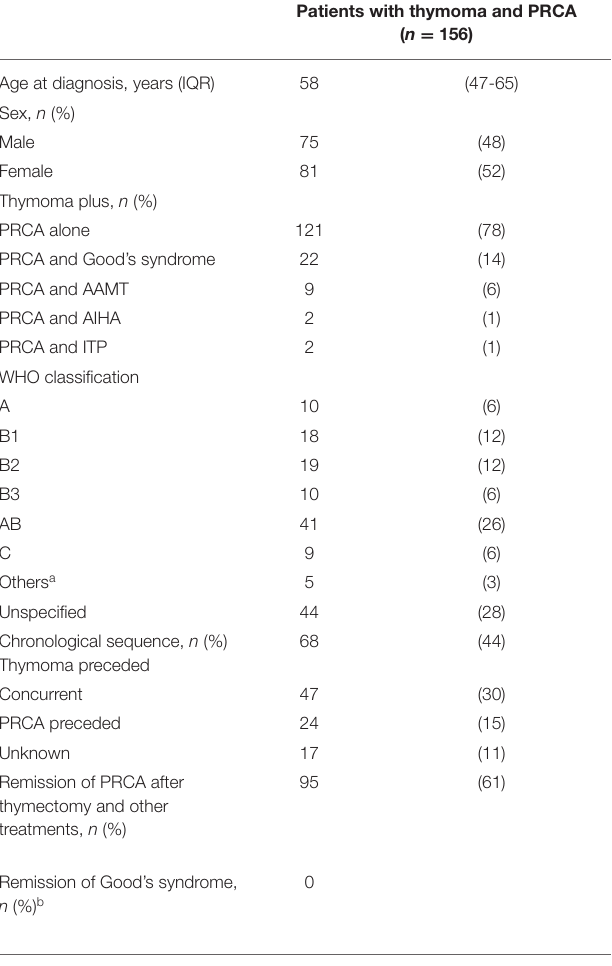
TABLE 5 | Pooled analysis of present series and the literature.